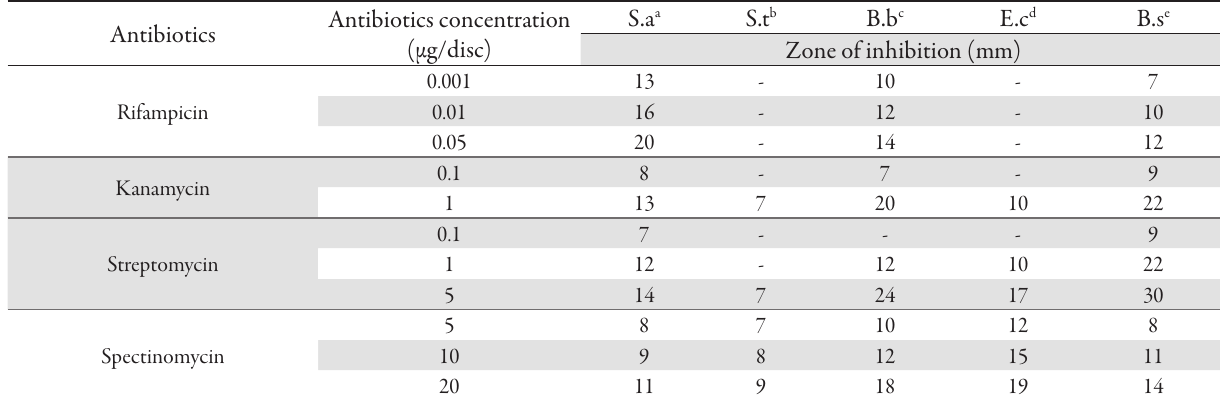
Tab. 3. Analysis of antibacterial activity of standard antibiotics against different bacteria including pathogens